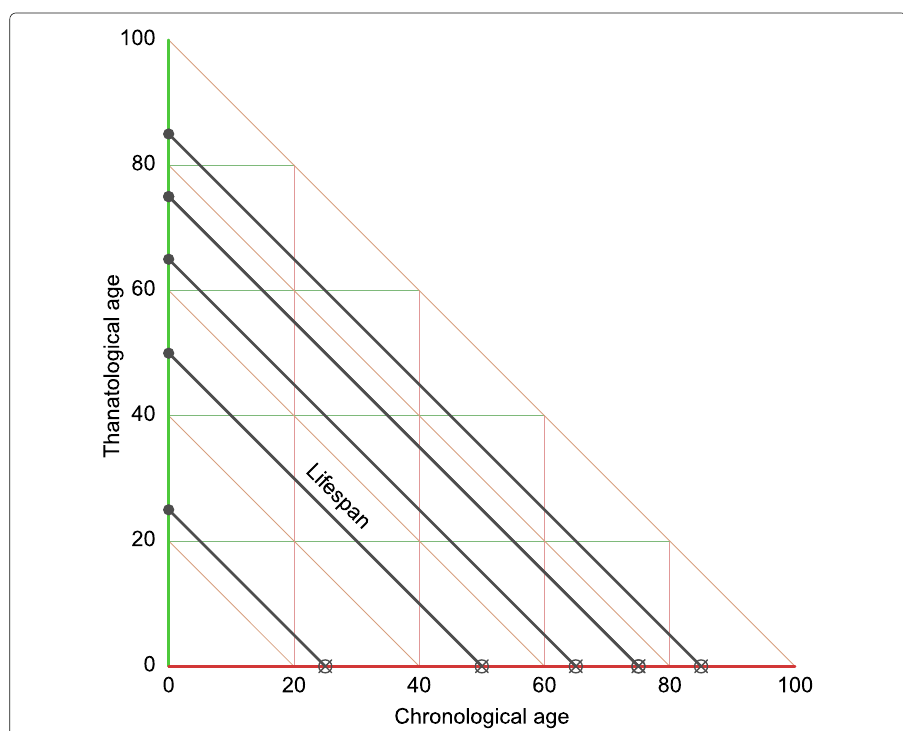
Fig. 3 A TAL diagram with six lifelines. Since two of the six lifelines are of equal length (75), they are overlapped in this figure and appear to be five